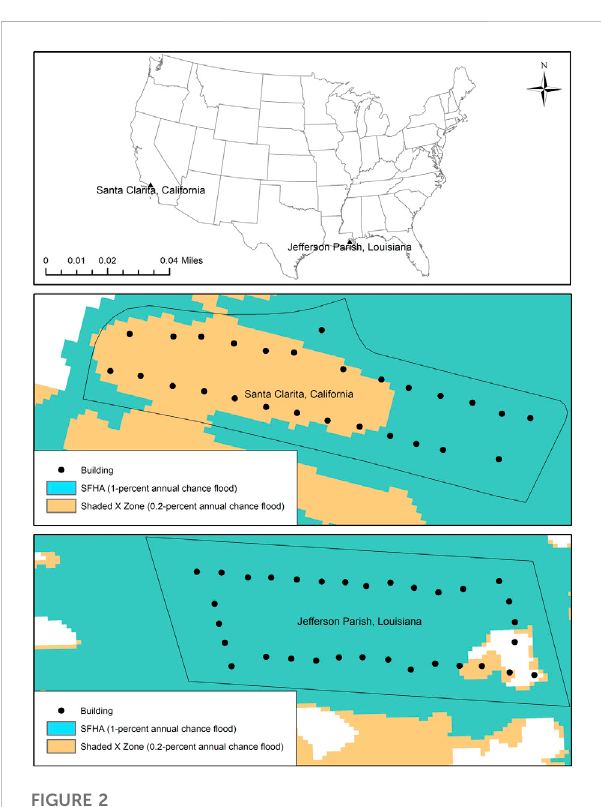
Generating the synthetic, unique u and a for the shaded X Zone begins with substituting for p from Eq. (3) into Eq. (2), for the 100 (i.e., T )-year return period, for which d is assumed to be less than or equal to zero in the shaded X Zone, as shown in Eq. (4):